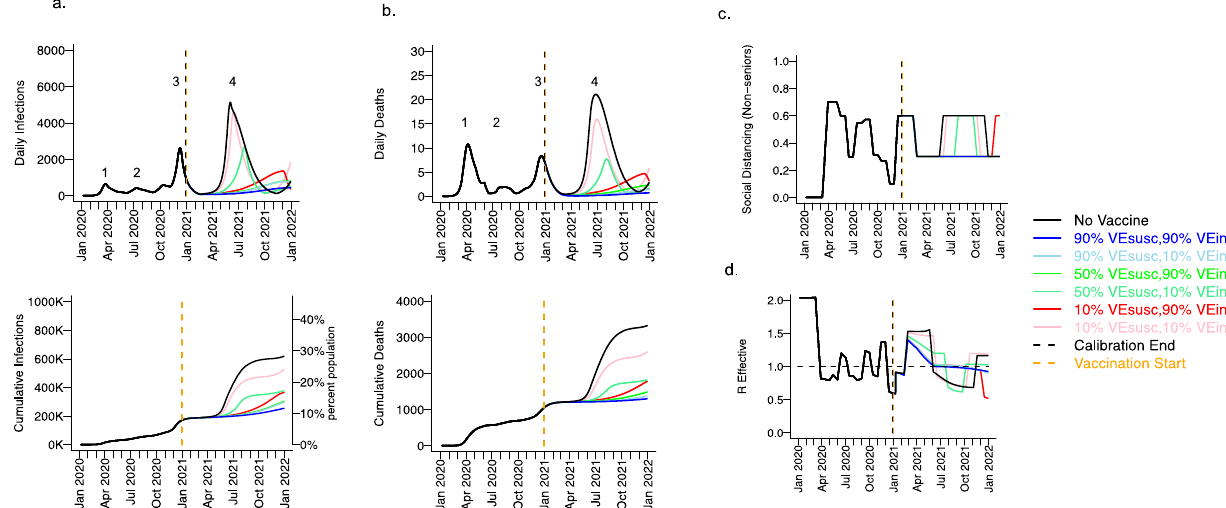
Figure 3. High VE SUSC or high VE INF can effectively limit infections and deaths with the B.1.1.7 variant. For unvaccinated (black lines) and each vaccine cohort (colored lines, legend), we project ( a ) infections, ( b ) deaths, as well as ( c ) social distancing relative to pre-pandemic levels and ( d ) the effective reproductive number. The first two columns ( a , b ) are organized by row: top = daily incidence, bottom = cumulative. Waves of infection are numbered 1–4. Six combinations of VE SUSC and VE INF are considered while VE SYMP is fixed at 10%. High VE SUSC (90%) simulations are blue and have similar outcomes to one another. Moderate VE SUSC (50%) simulations are green. Low VE SUSC (10%) simulations are red/pink. Dark lines are high VE INF (90%). Light lines are low VE INF (10%). The largest reduction in infections is associated with either high VE SUSC or VE INF . 10,000 vaccines are given per day starting 1 January 2021 (orange line) until 90% are vaccinated in age groups other than children. Case threshold for reinstituting physical distancing to 0.6 is 350 per 100,000 and for relaxation is 100 per 100,000. 80% of vaccines are initially allocated to the elderly with the remaining 20% to middle-aged cohorts.